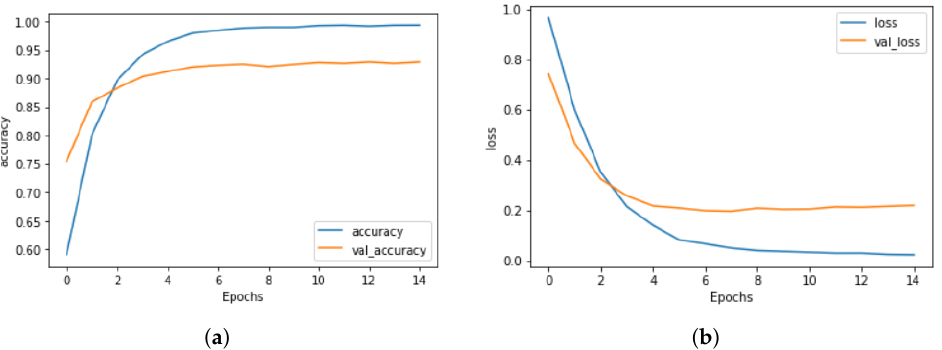
Figure 13. Accuracy and loss ROC curves of proposed feed forward neural network: ( a ) training and validation accuracy; ( b ) training and validation